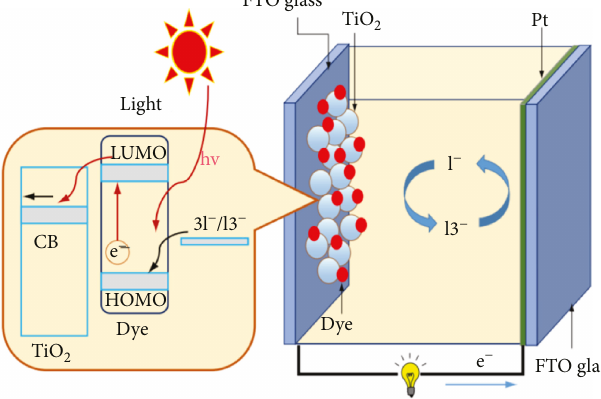
Figure 1: Scheme diagram of dye-sensitized solar cells